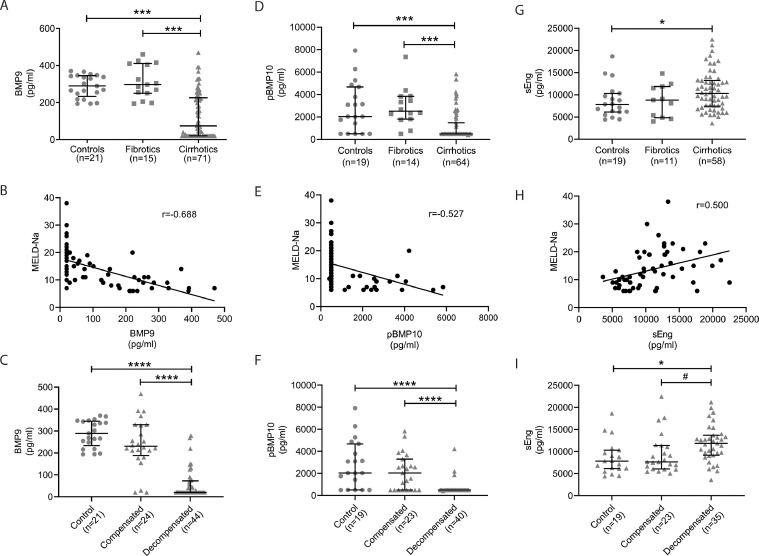
Reduced plasma BMP9 and pBMP10 levels and increased sEng levels in cirrhosis are associated with decompensation. (A,D,G) Plasma samples from controls or patients with either pre-cirrhotic liver fibrosis or with cirrhosis were assayed by ELISA for (A) BMP9, (D) pBMP10 or (G) sEng. Error bars show median and interquartile range. (B,E,H) Spearman correlation of: (B) BMP9 (n = 69, P<0.0001), (E) pBMP10 (n = 64, P<0.0001) or (H) sEng (n = 58, P<0.0001) levels with MELD-Na score of cirrhosis severity. (C,F,I) Patients were stratified for compensated and decompensated liver disease and plasma levels of (C) BMP9, (F) pBMP10 and (I) sEng compared between groups. Kruskal Wallis test: *P<0.05, ***P<0.001, ****P<0.0001, Mann Whitney Test #P<0.05.